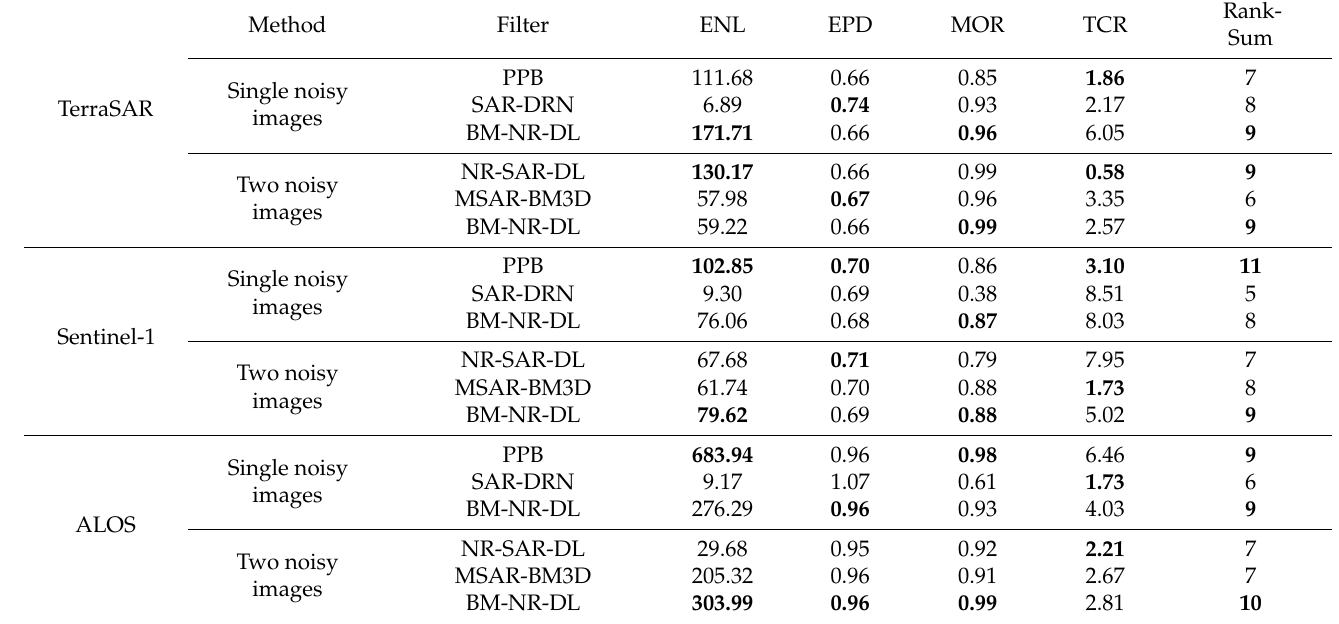
Table 3. Quantitative assessment results for the TerraSAR, Sentinel-1, and ALOS